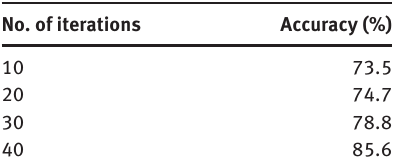
Table 3: Accuracy Value of Proposed Method by Varying the